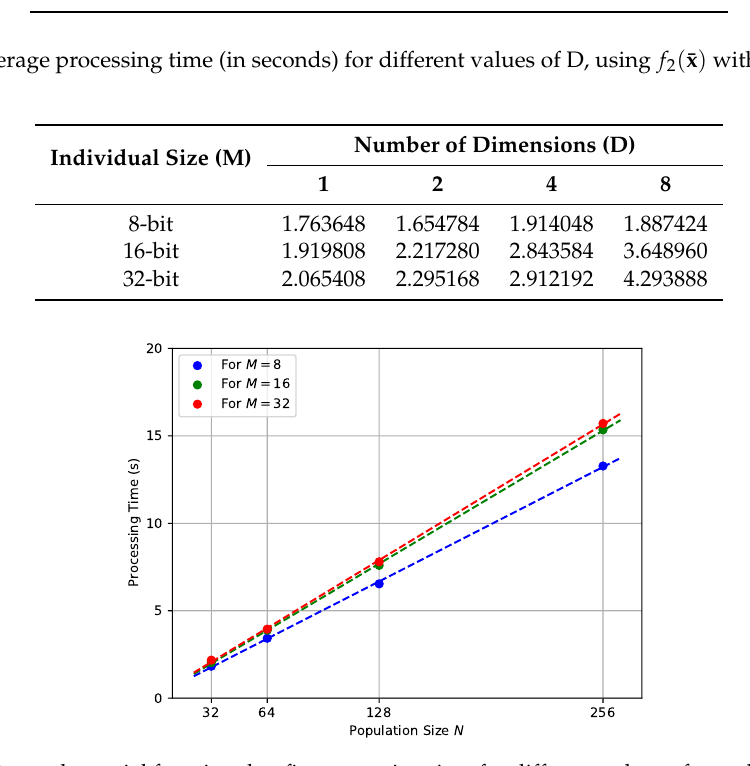
Figure 12. Best polynomial function that fits processing time for different values of population size, N